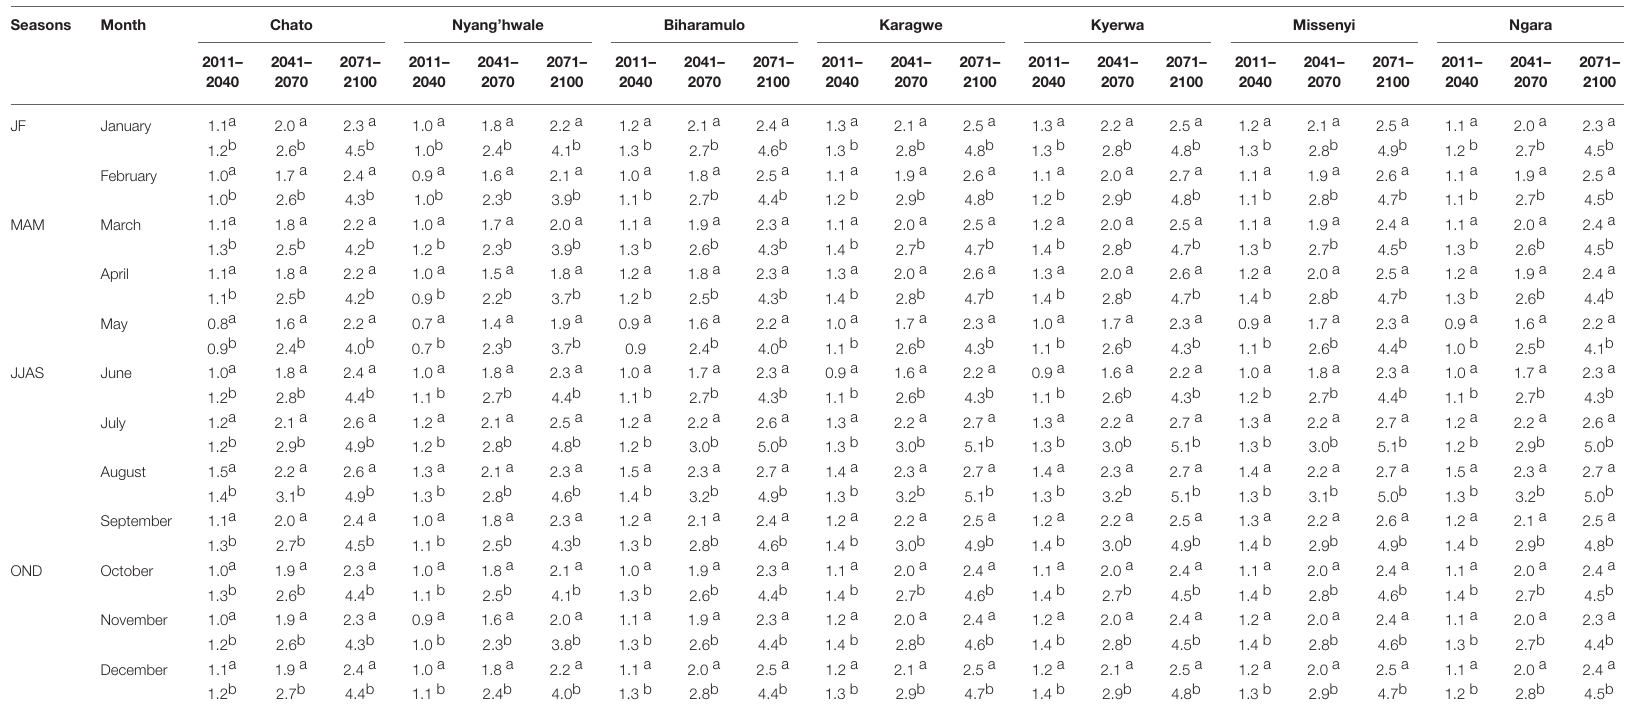
TABLE 6 | Projected change in minimum temperature ( ◦ C) in the Kagera and Geita regions during the present (2011–2040), mid (2041–2070), and end (2071–2100) century for Representative Concentration Pathway a (RCP) 4.5 scenario and b RCP 8.5 scenario. Seasons Month Chato